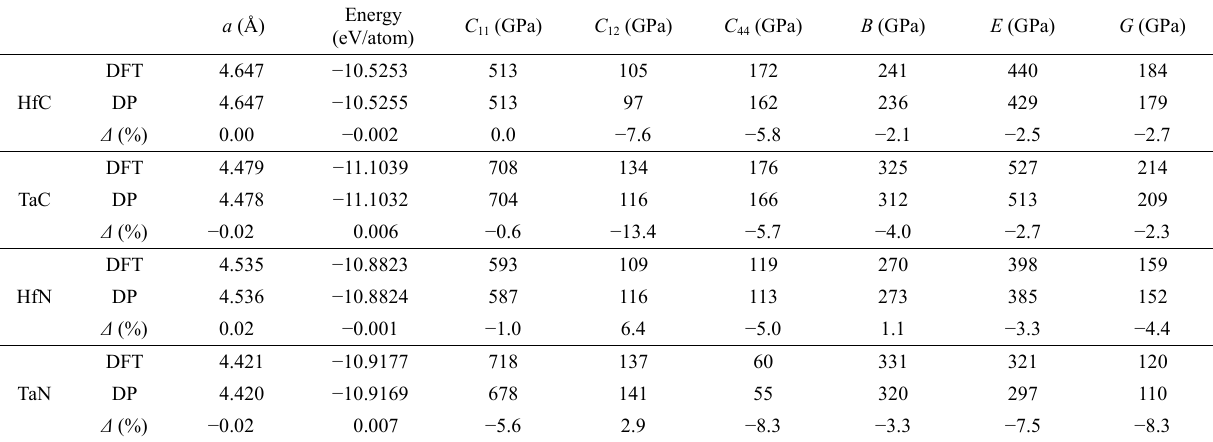
Fig. 1 Comparison of (a) energy and (c) force predicted by the DP model with DFT calculations and probability density distributions of prediction errors on (b) energy and (d) force. Table 1 Comparison of DP prediction results with DFT calculations. DFT values were calculated with spacing of k -point mesh being 0.05 Å − 1 . Δ is relative error between DP prediction and DFT calculations, which is ( v DP − v DFT )/ v DFT . v DP means the value predicted by DP, while v DFT means the value predicted by